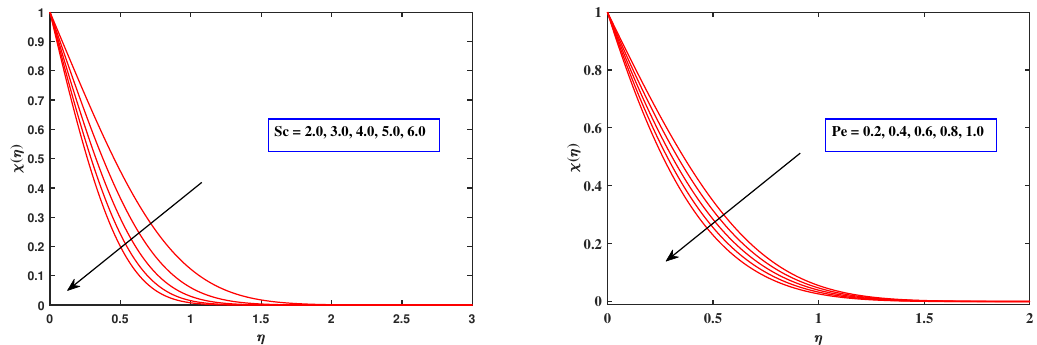
Figure 8. Fluctuation in motile density profile with Sc and Pe